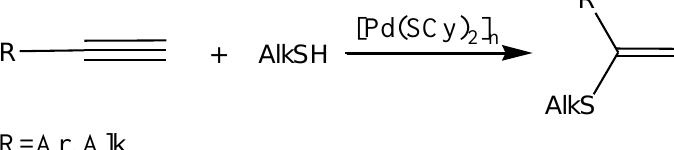
Figure 12. Microphotograph of [Pd(SCy)